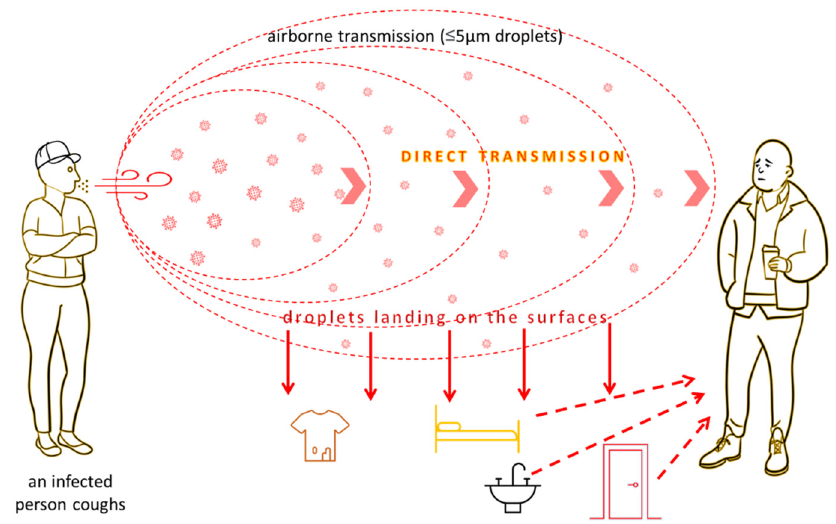
Figure 3. Potential routes of COVID-19 spread from coughing by an infected person.